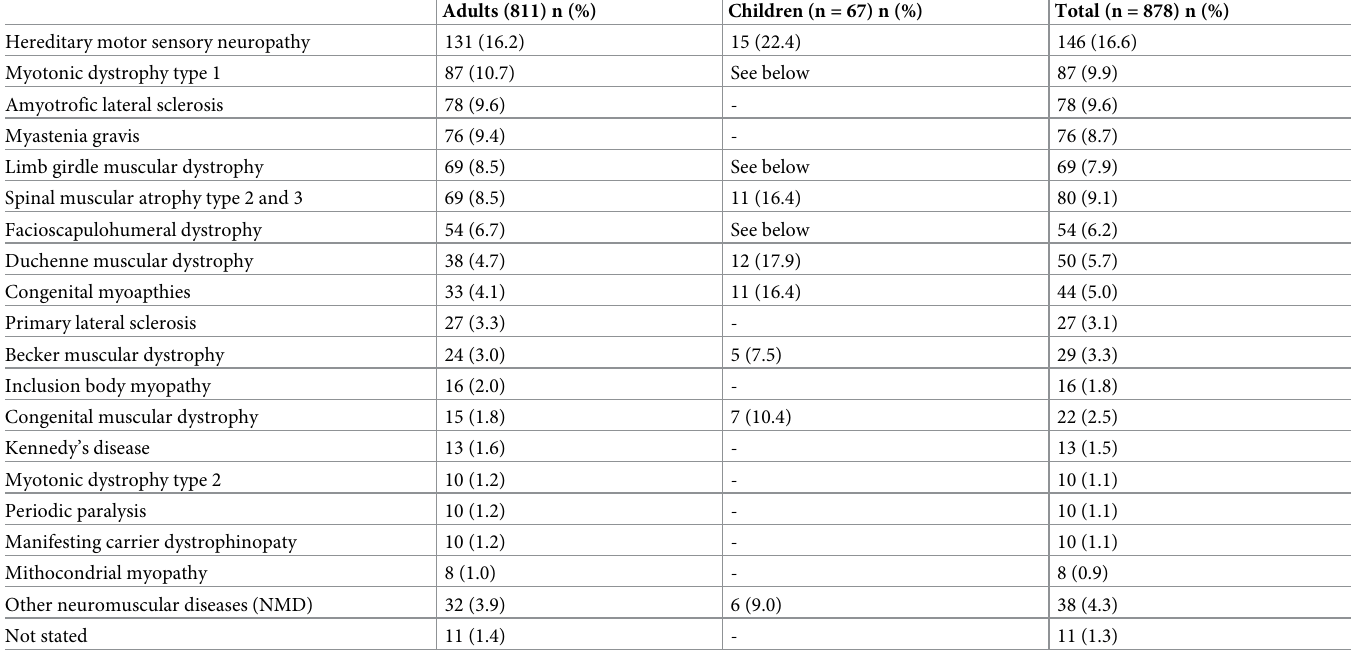
Table 2. Diagnoses of